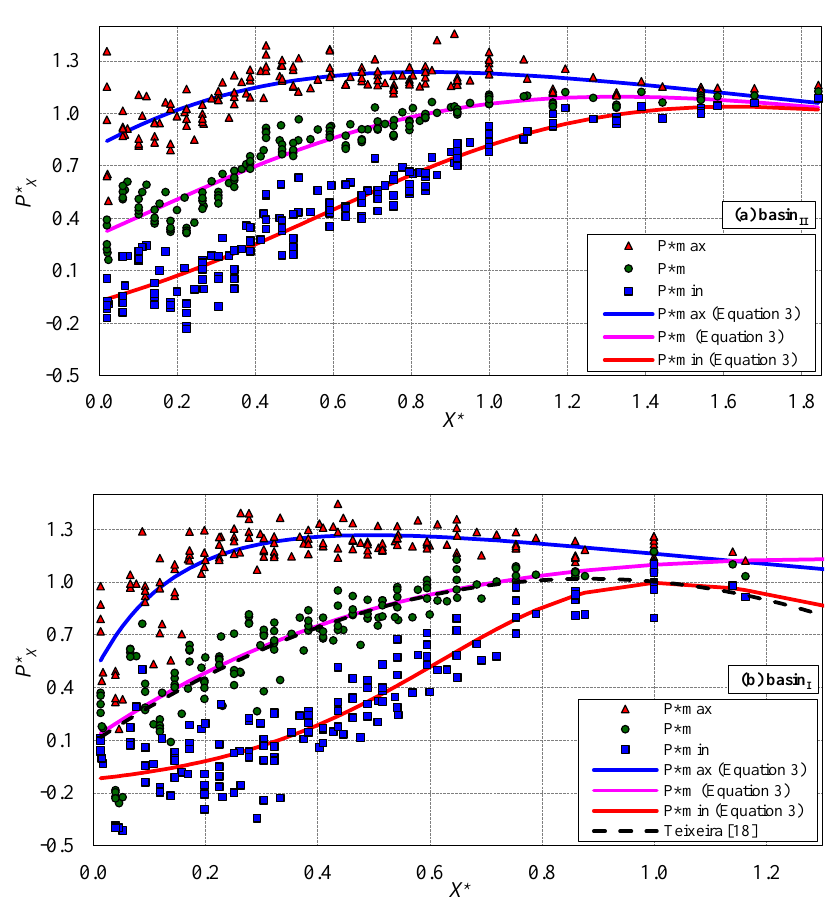
Figure 6. Distribution of the experimental and estimated values of P * X : ( a ) basin II ; ( b ) basin I .